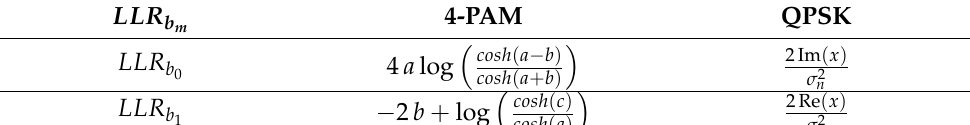
Table 1. Closed-form expressions for the LLR b